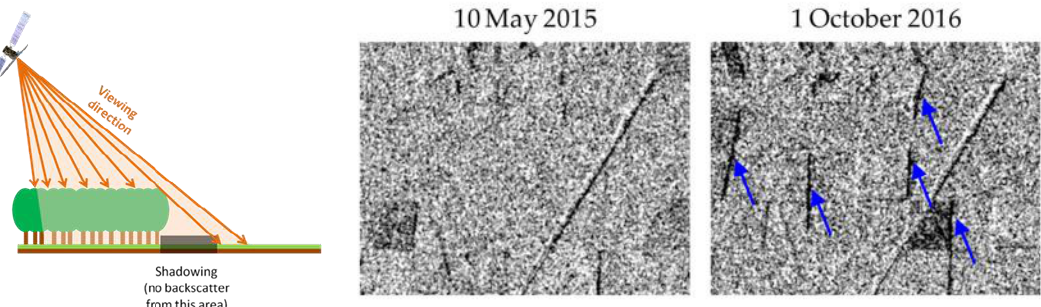
Figure 4. Illustration of the S-1 C-band SAR shadowing effect at the border between forests and deforested area. Left: schematic illustration, middle: 10m C-band S-1 SAR image before forest disturbance, right: 10m C-band S-1 SAR image after forest disturbance: the arrows point at the new shadows.